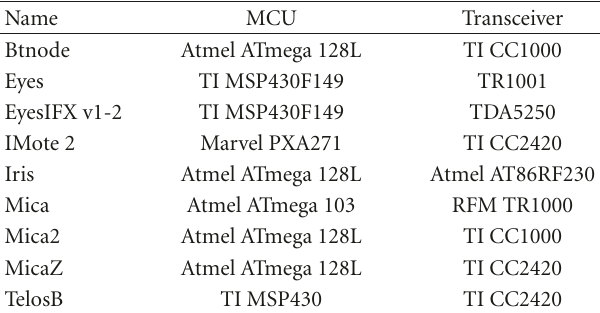
Table 1: List of typical sensor